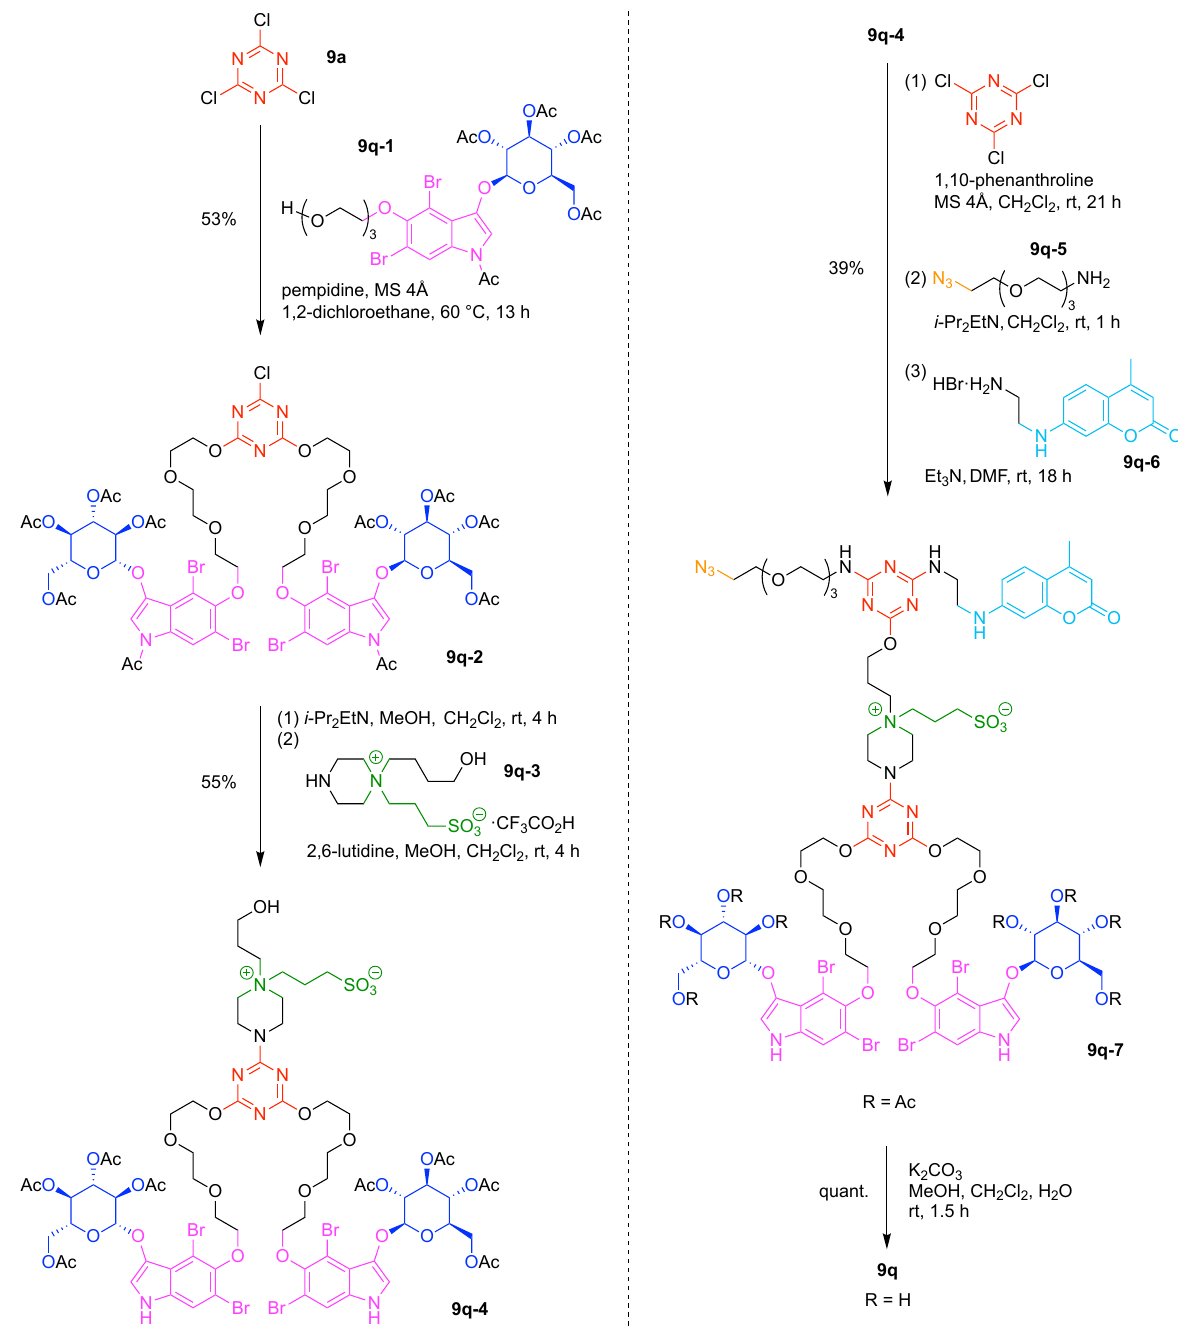
Figure 41. Synthesis of a bioconjugatable compound, built around triazine hubs, that enables enzymatically triggered cross-linking chemistry.